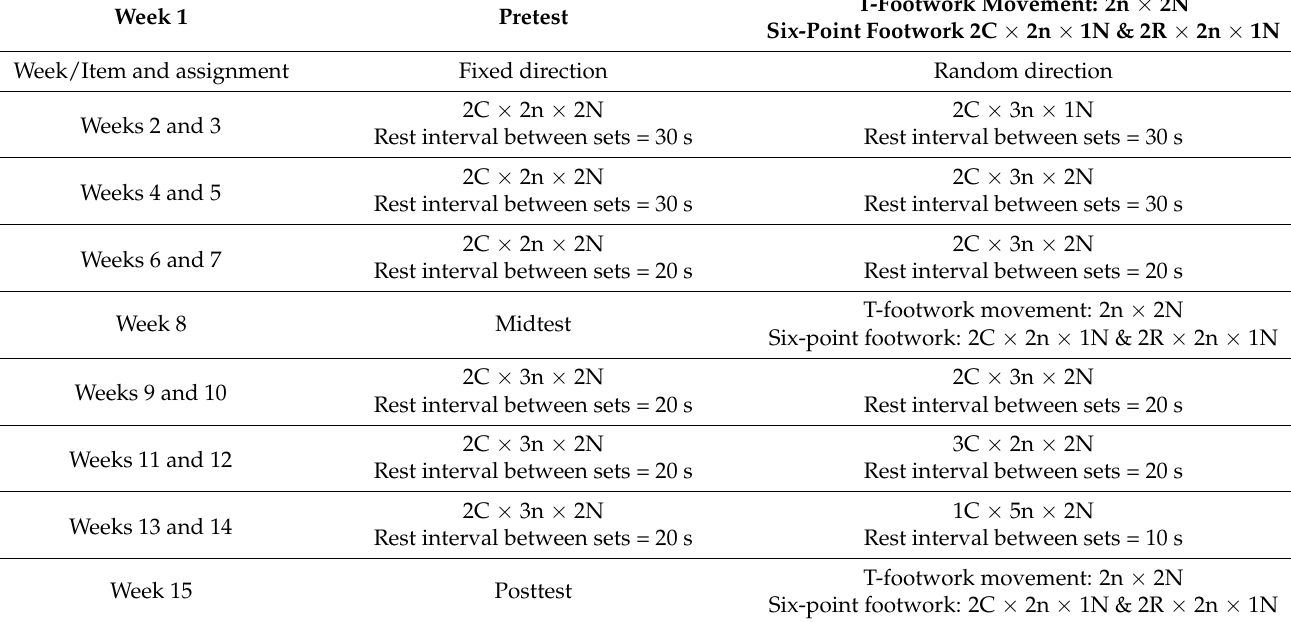
Table 1. Training